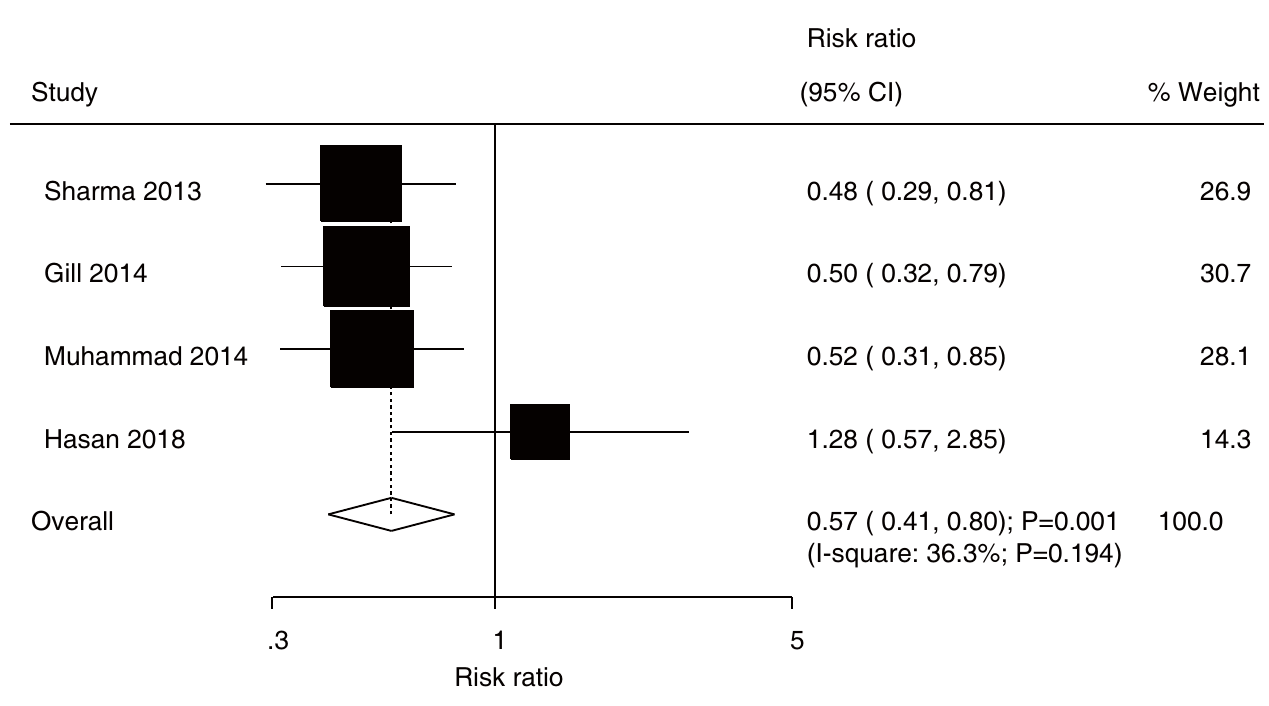
Meta−analysis estimates, given named study is omitted